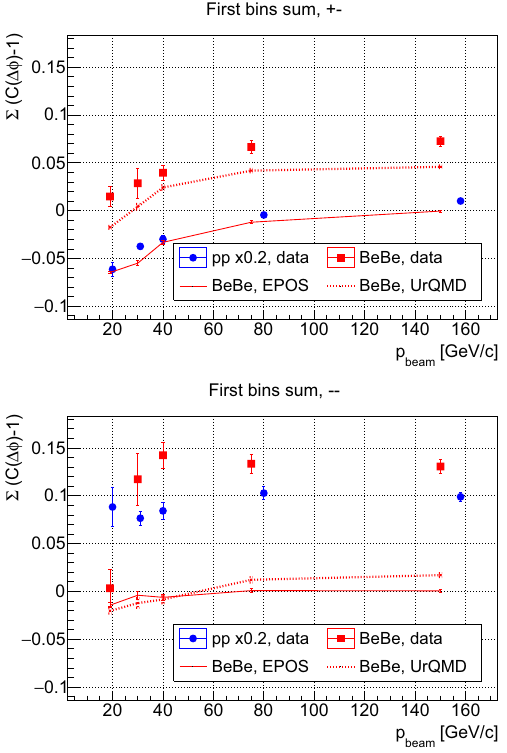
ResultsforBe+Be(redsquares)werecomparedwithp+p(bluecircles) and with model predictions of the corresponding charge combination. The results of p + p are scaled down by factor of 5